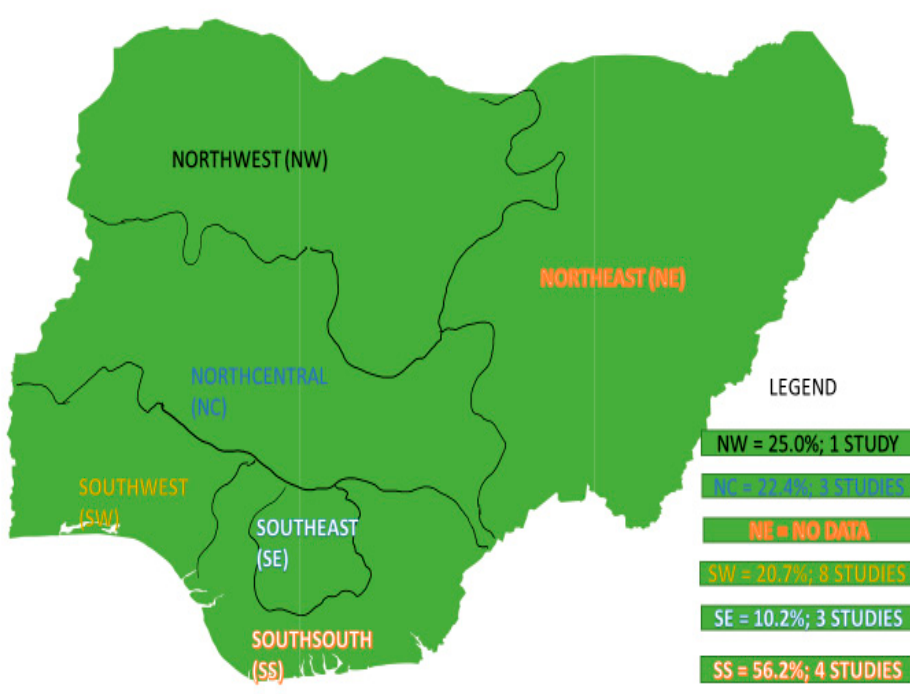
Figure 2. Spatial distribution and number of studies of VRE in Nigeria based on data extracted from eligible studies.